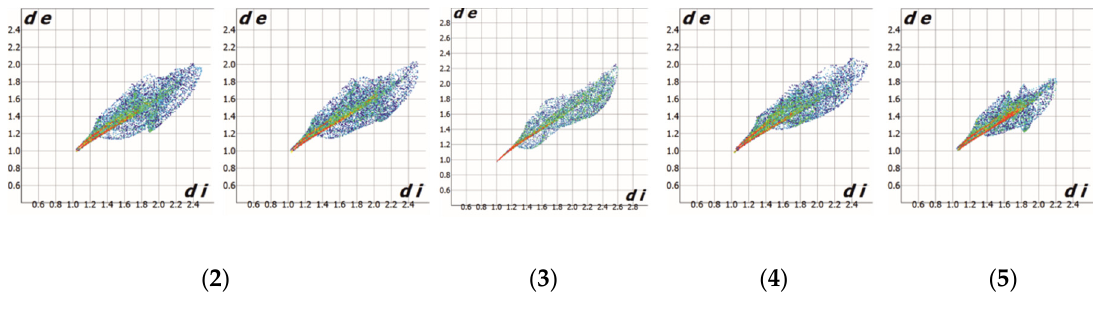
Figure 3. Fingerprint plot for the Hirshfeld surface of the metallic center of ( 2 ), ( 3 ), ( 4 ), and ( 5 ).